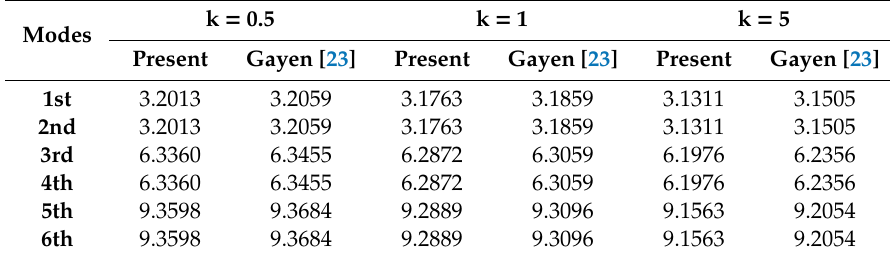
Table 3. Natural frequencies for a nonrotating simply supported functionally graded (FG) shaft.